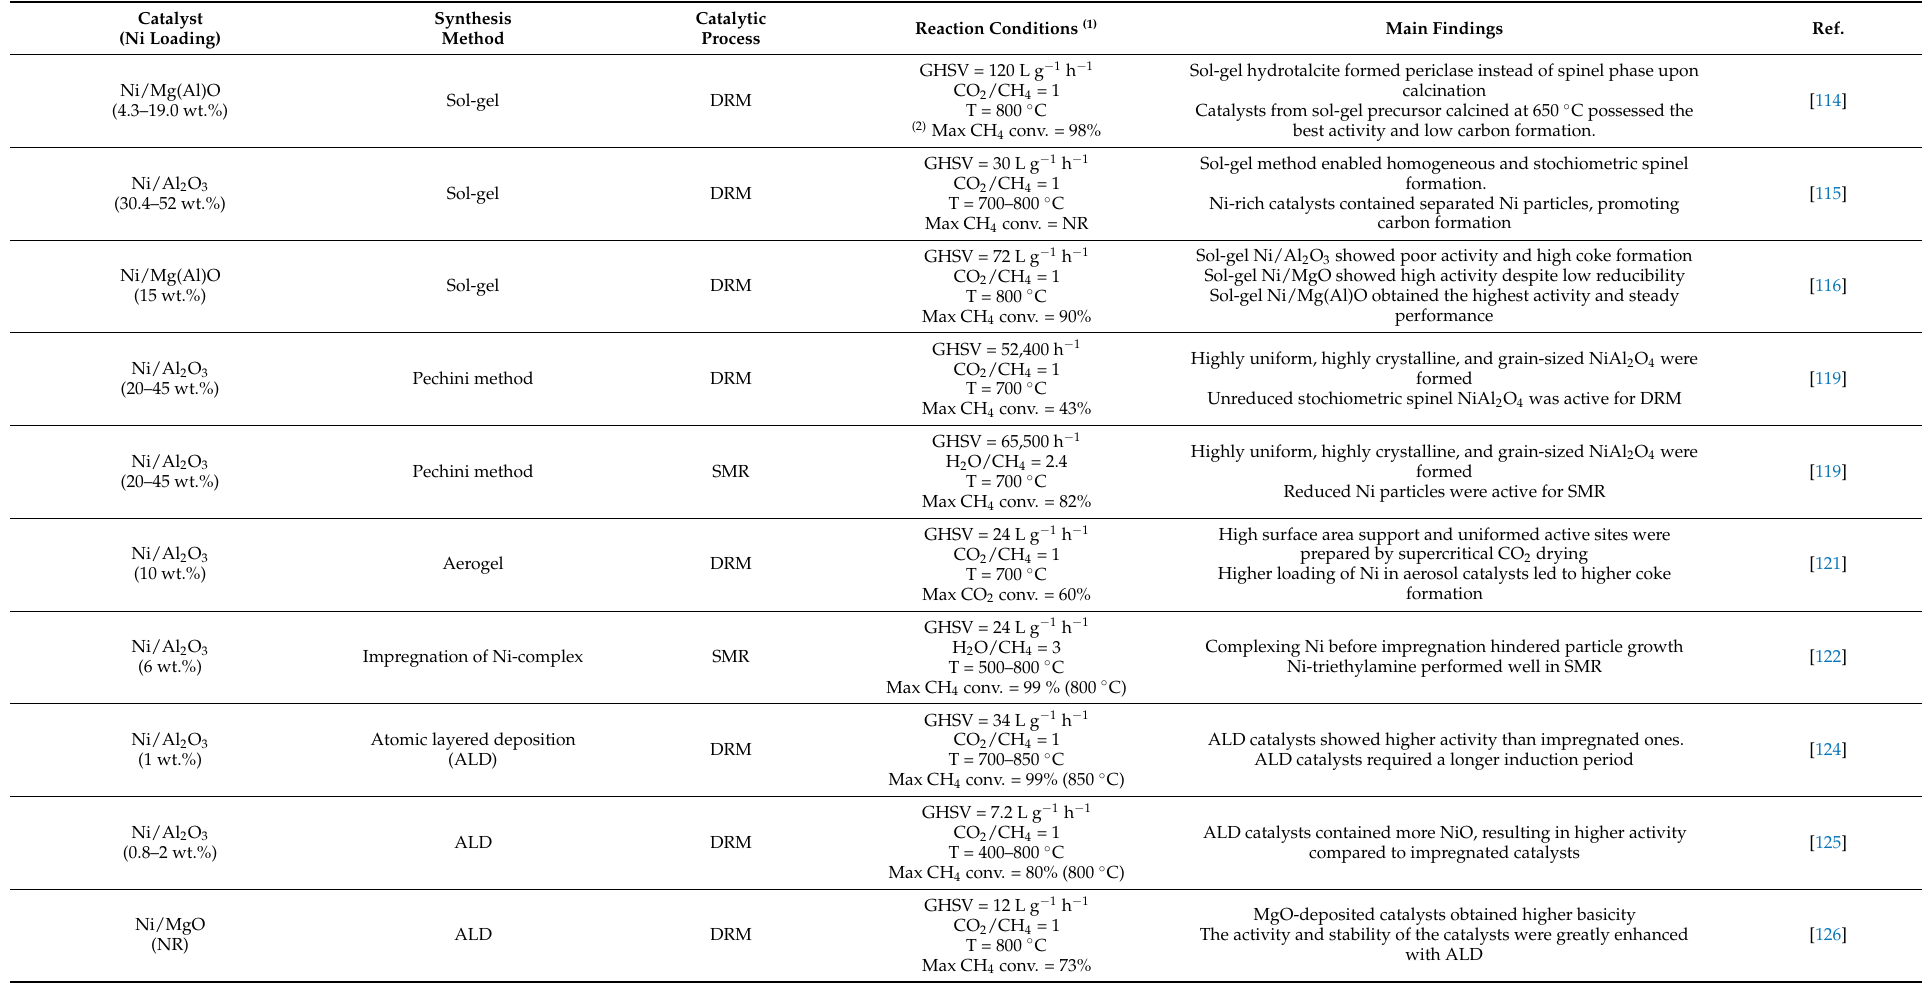
Table 4. Monometallic Ni catalysts supported on Mg(Al)O obtained by advanced methods for SMR and